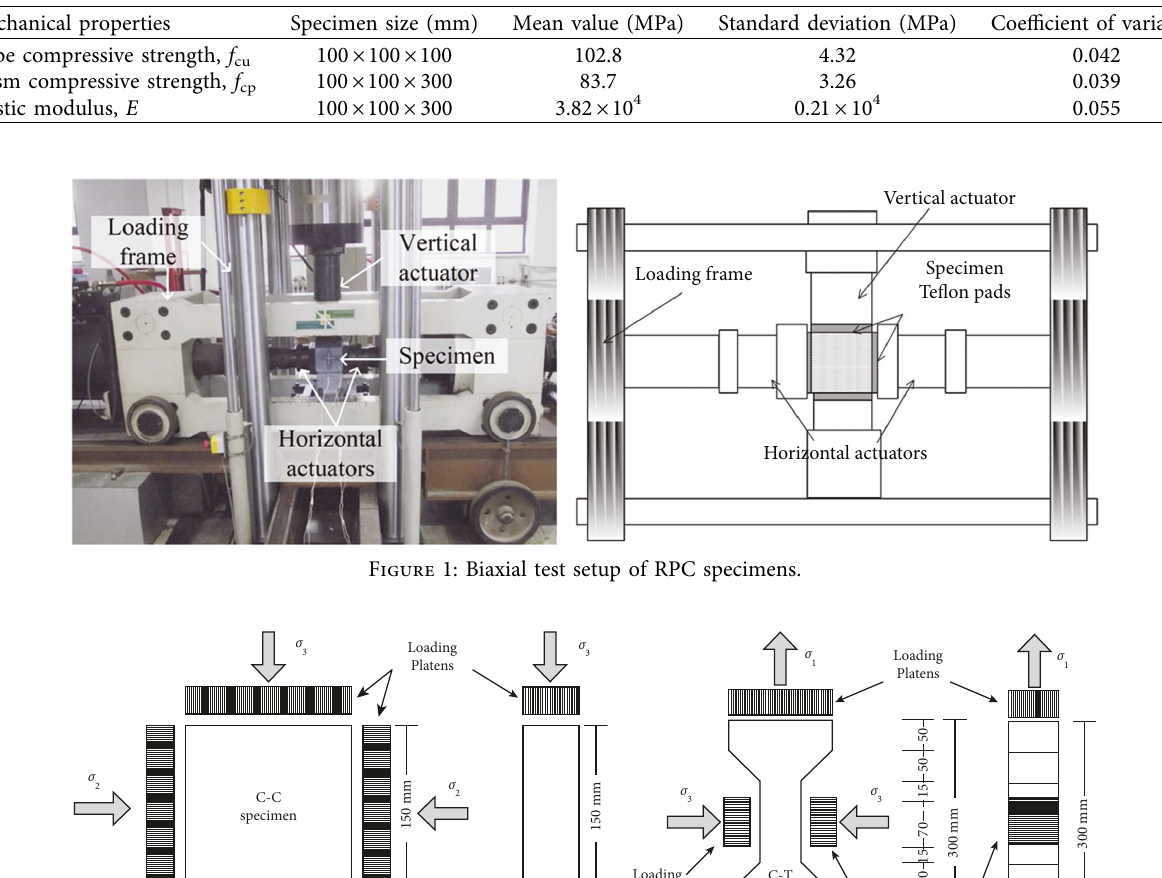
Table 2: Basic mechanical properties of specimens.